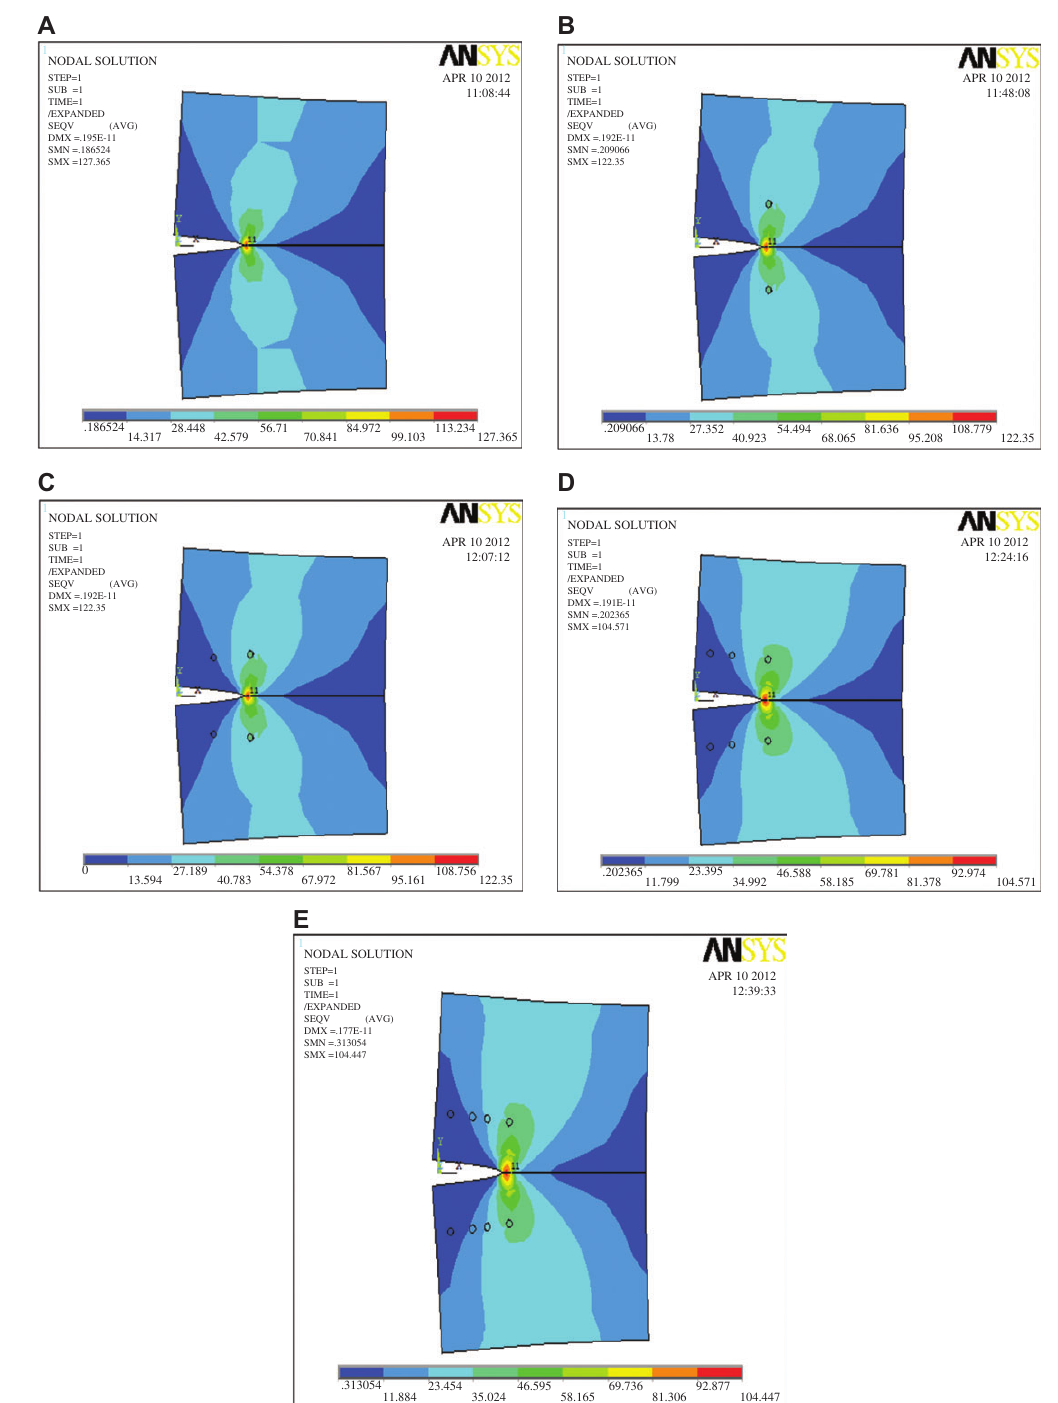
Figure 9 (A) Stress intensity factor in 0 wt.- % micro-TiO A384 alloy composites. (C) Stress intensity factor in 4 wt.- % micro-TiO micro-TiO -filled A384 alloy composites. (E) Stress intensity factor in 8 wt.- % micro-TiO 2